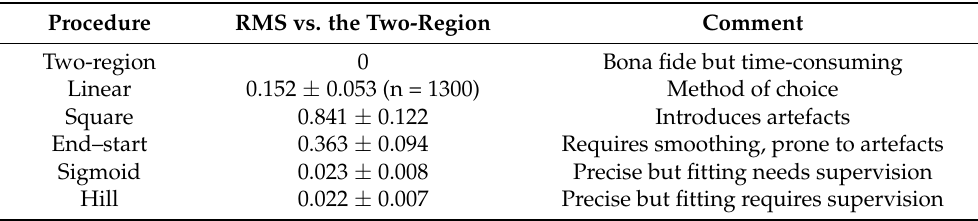
Table 2. Root square means of differences between the agonist effect assessed via the two-region approach (Figure S2a) and single-region algorithms (Figure